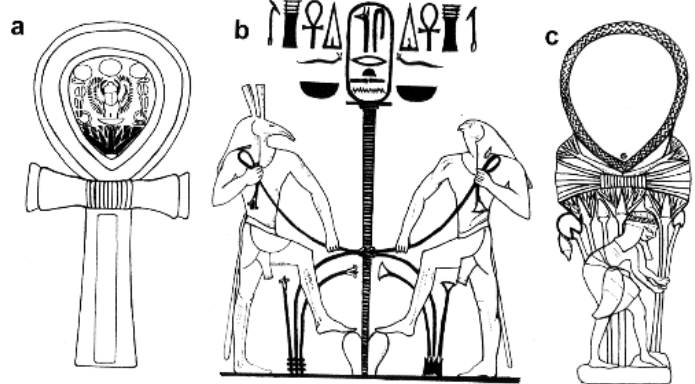
Figure 3. Ankh and lotus. ( a ) Mirrors and mirror cases from Egyptian tombs are often fashioned in the image of an ankh symbol and a flowering lotus stalk. Note that the stalked shen loop (an ankh) contains a lotus blossom and three golden floral disks. The triad of disks presumably symbolizes the natural three-day life span of a lotus flower. Thebes, Valley of the Kings, Tomb of Tutankhamen, 14th c. BCE (Cairo Museum). ( b ) Horus and Seth grasp a lotus and papyrus stalk and sustain the immortal phallus of Osiris-Ra. The phallic symbol takes the form of an ankh symbol and contains a hieroglyphic reference to Seti I. Abydos, 13th c. BCE (Cairo Museum). ( c ) Unguent spoons were often fashioned in the image of an ankh, stalked shen loop, and flowering lotus stalk. Note that the extended arms of the shen loop terminate in lotus blossoms and that a lotus bud and blossom motif—a symbol of immortal life—extends across the spoon. Thebes, Egypt, 13th c. BCE (Louvre Museum).